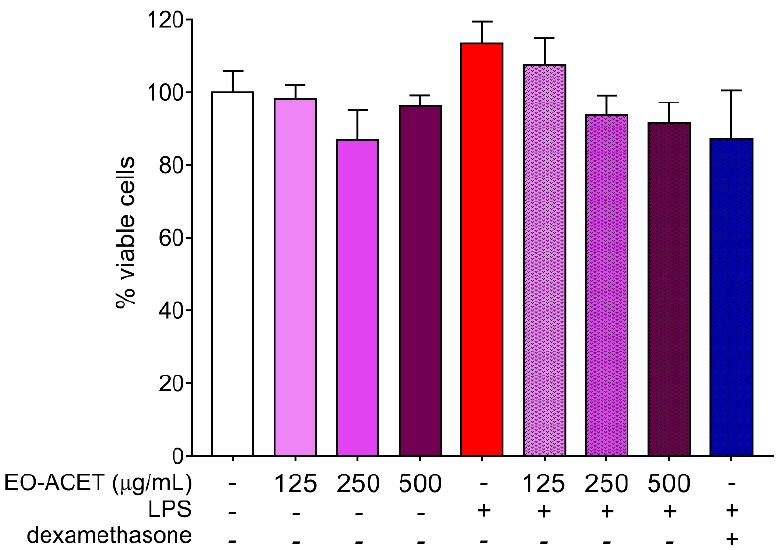
Figure 3. Cytotoxicity of Euterpe oleracea ethyl acetate fraction (EO-ACET) in RAW 264.7 cells after 48 h of treatment with EO-ACET (purple columns) or dexamethasone (blue column) at 100 µM and stimulated, or not, with LPS (red column) at 10 µg/mL. Data represent the mean ± standard deviation of the experiment performed in sextuplicate.